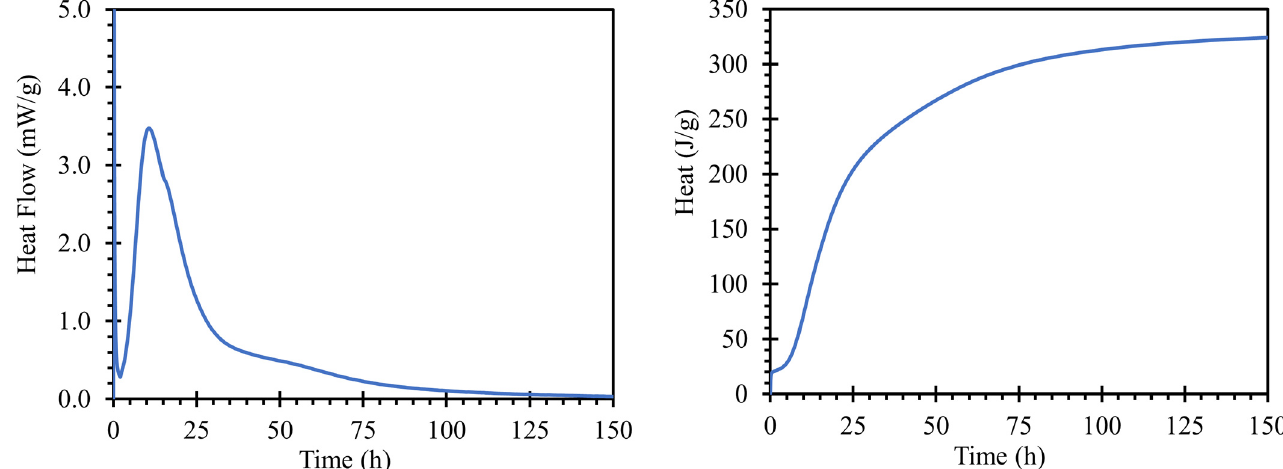
Figure 2. Hydration kinetics of used road cement using water to cement ratio of 0.3 recorded by means of isothermal